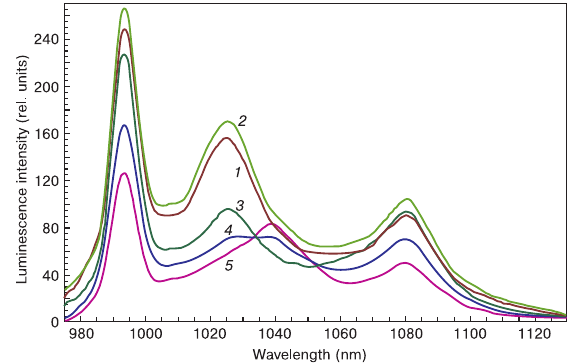
Yb Na )Ga O luminescence spectra excited 1- х - y х y 2 4